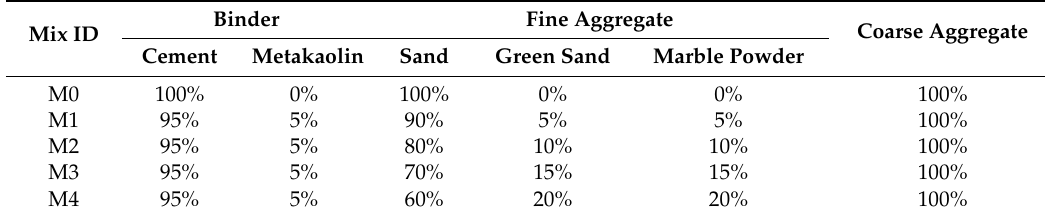
Table 2. Level of Replacement in binder and